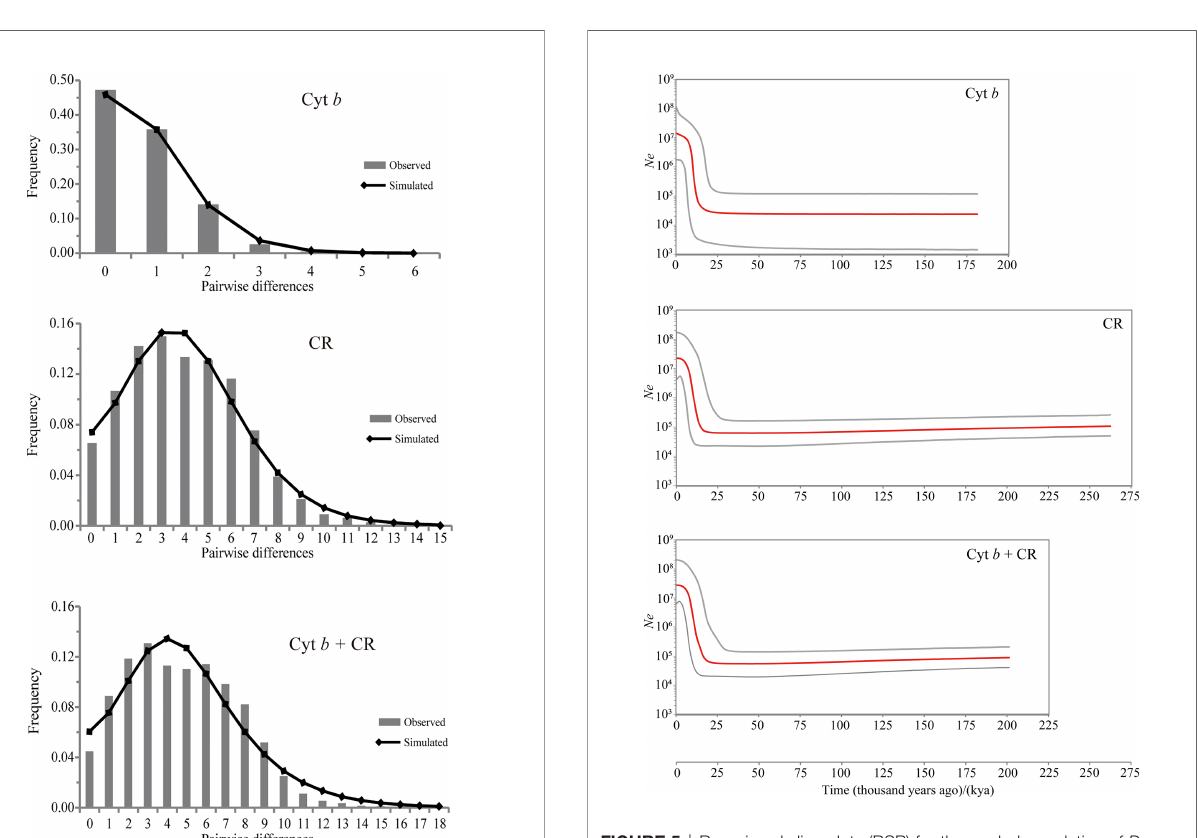
FIGURE 5 | Bayesian skyline plots (BSP) for the pooled population of D. maruadsi based on Cyt b , CR, and concatenated sequences (Cyt b + CR). Intermediate red line represents the median of effective population size ( Ne ), and the gray lines indicate the upper and lower 95% highest posterior density (HPD) interval.